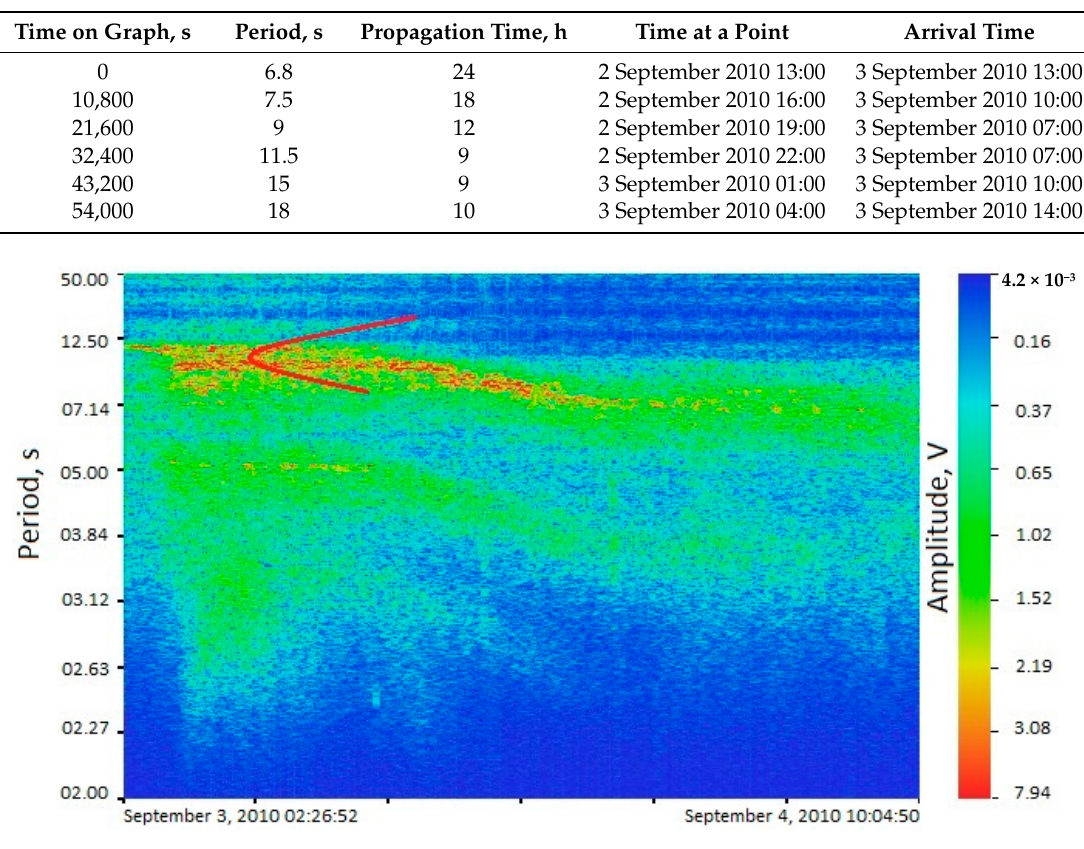
Figure 9. Calculated Doppler effect.